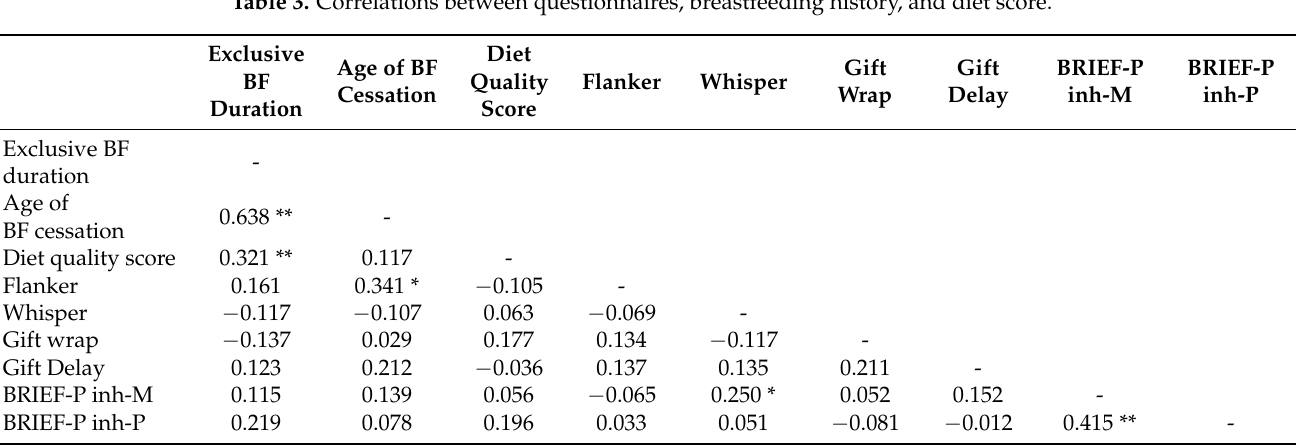
Table 3. Correlations between questionnaires, breastfeeding history, and diet